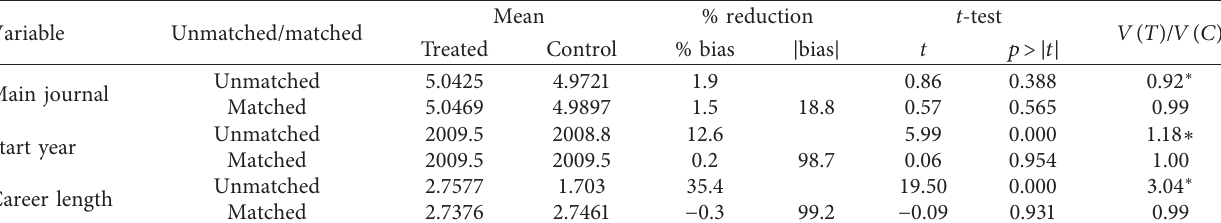
Table 10: L-index balance